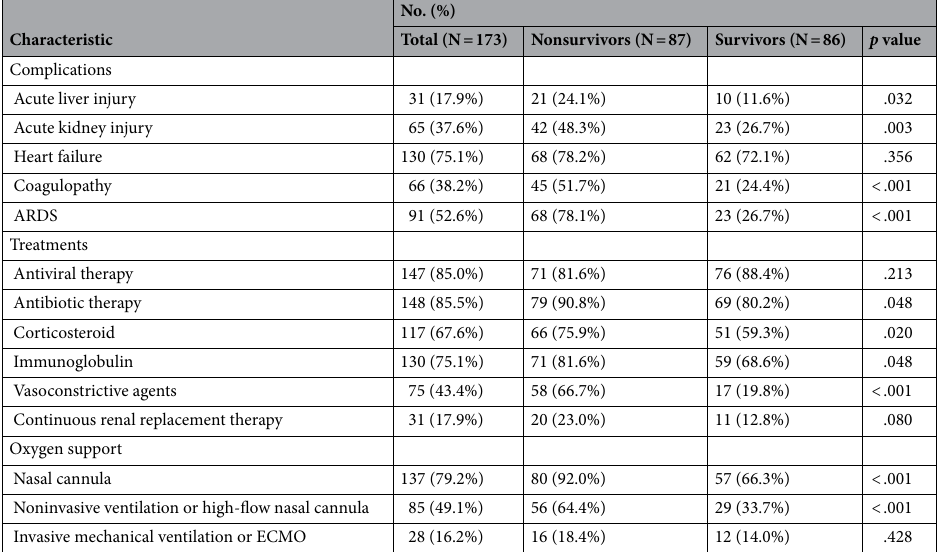
Table 3. Complications and treatments of COVID-19 patients with cardiac injury. ARDS, acute respiratory distress syndrome; ECMO, extracorporeal membrane oxygenation.